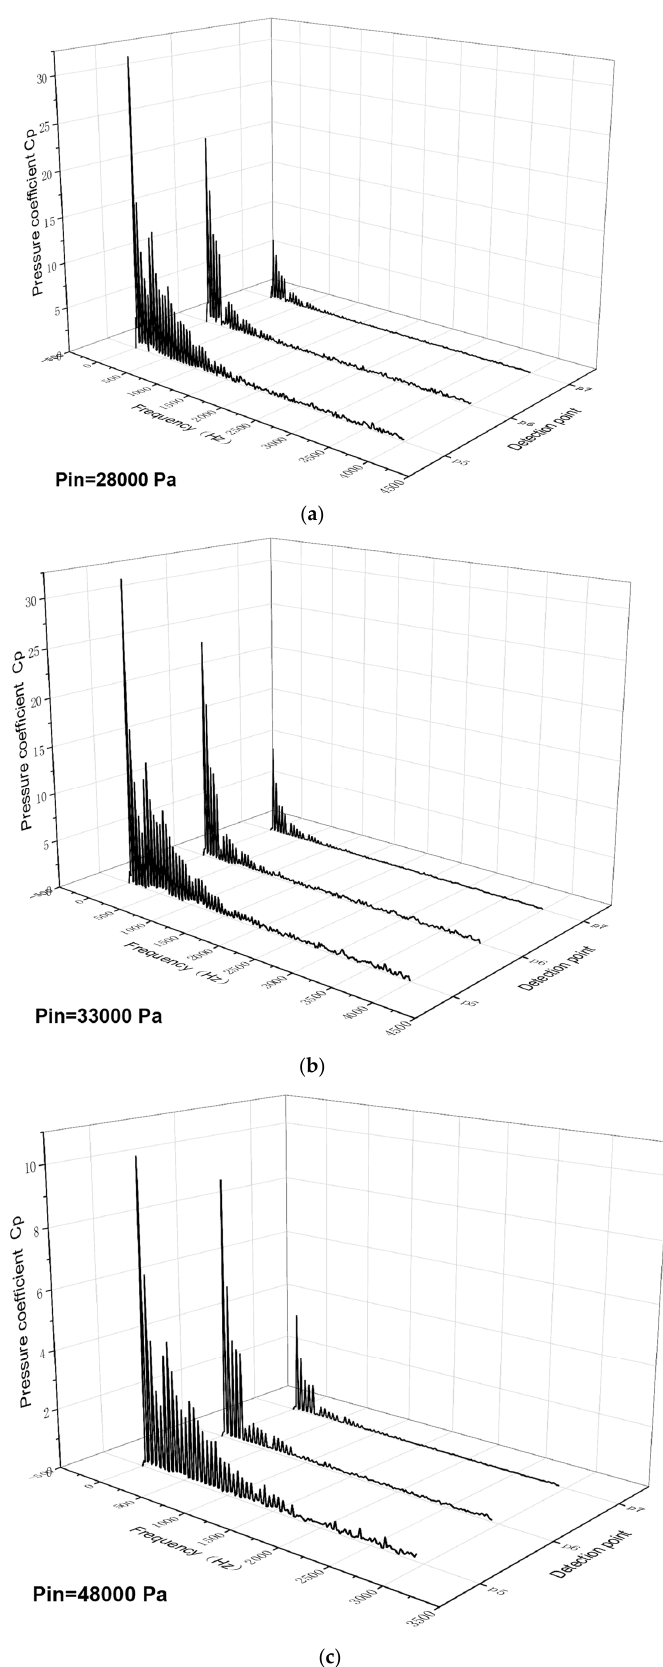
Figure 16. ( a – c ) Frequency-domain diagram of pressure pulsation at the suction surface of the blade.